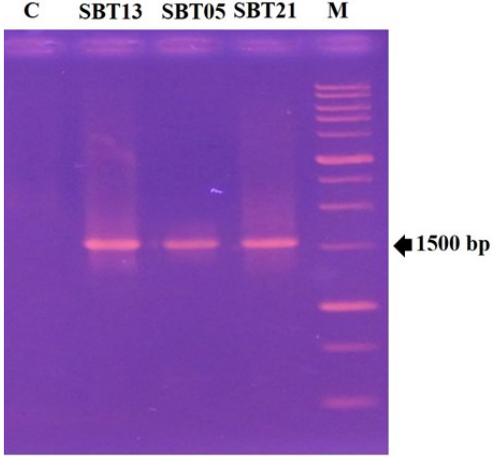
Fig. 4. Agarose gel electrophoresis of PCR- products of representative strains with primers rD1 and fD1: M꞊ 1 KB ladder; SBT05; SBT13; SBT21 and C as negative